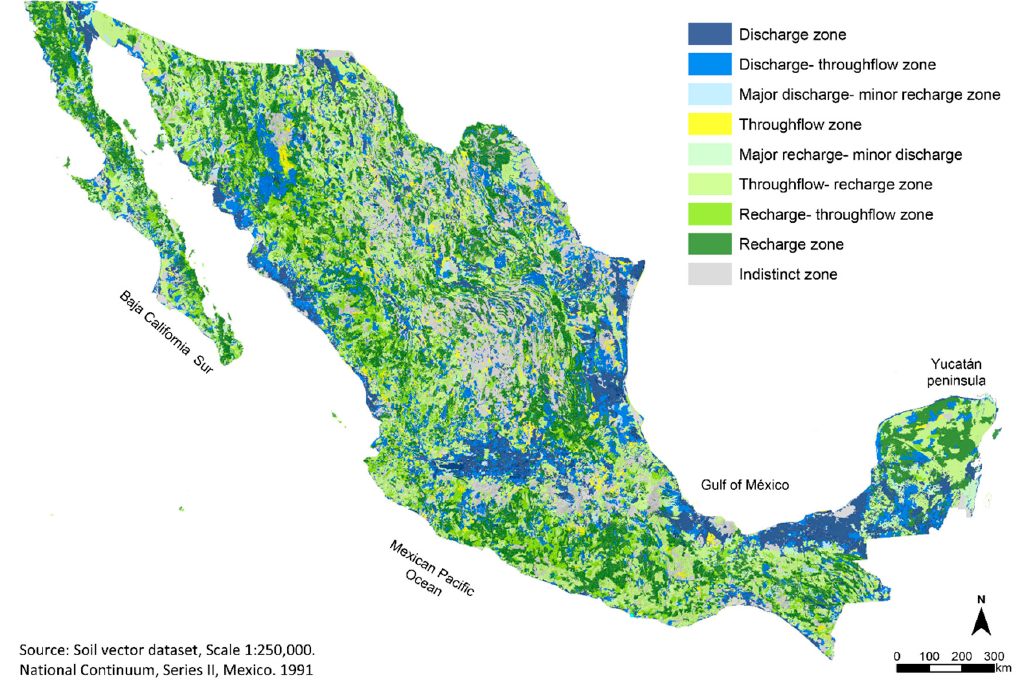
Figure 5. Hydrogeological association of soils.